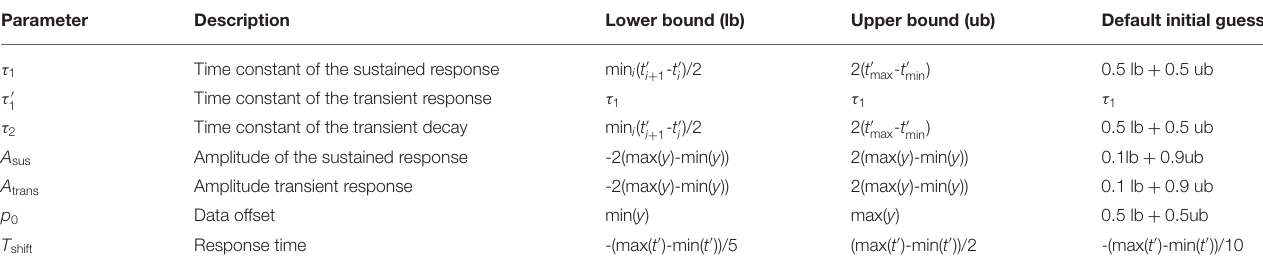
TABLE 1 | Suggested default values and parameter bounds.